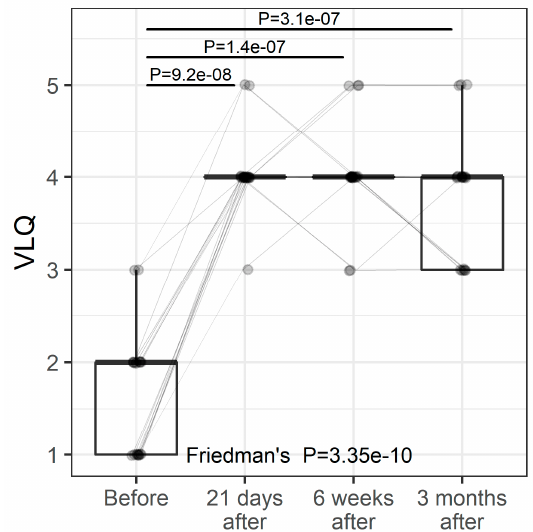
Figure 1. VLQ at study entry and follow-up visits (individual values and summary statistics). Individual values are represented by points joined by lines. Summary statistics are shown using box plots. The middle line of the box plot is median, the lower and upper hinges correspond to the first and third quartiles (the 25th and 75th percentiles). The upper whisker extends from the hinge to the largest value (no further than 1.5*IQR from the hinge, IQR is the interquartile range—distance between the first and third quartiles). The lower whisker extends from the hinge to the smallest value (no further than 1.5*IQR of the hinge). Median line overlaps with lower and upper hinges. p -values were determined using Friedman’s test, followed by pairwise post hoc Wilcoxon test with FDR adjustments for multiple testing